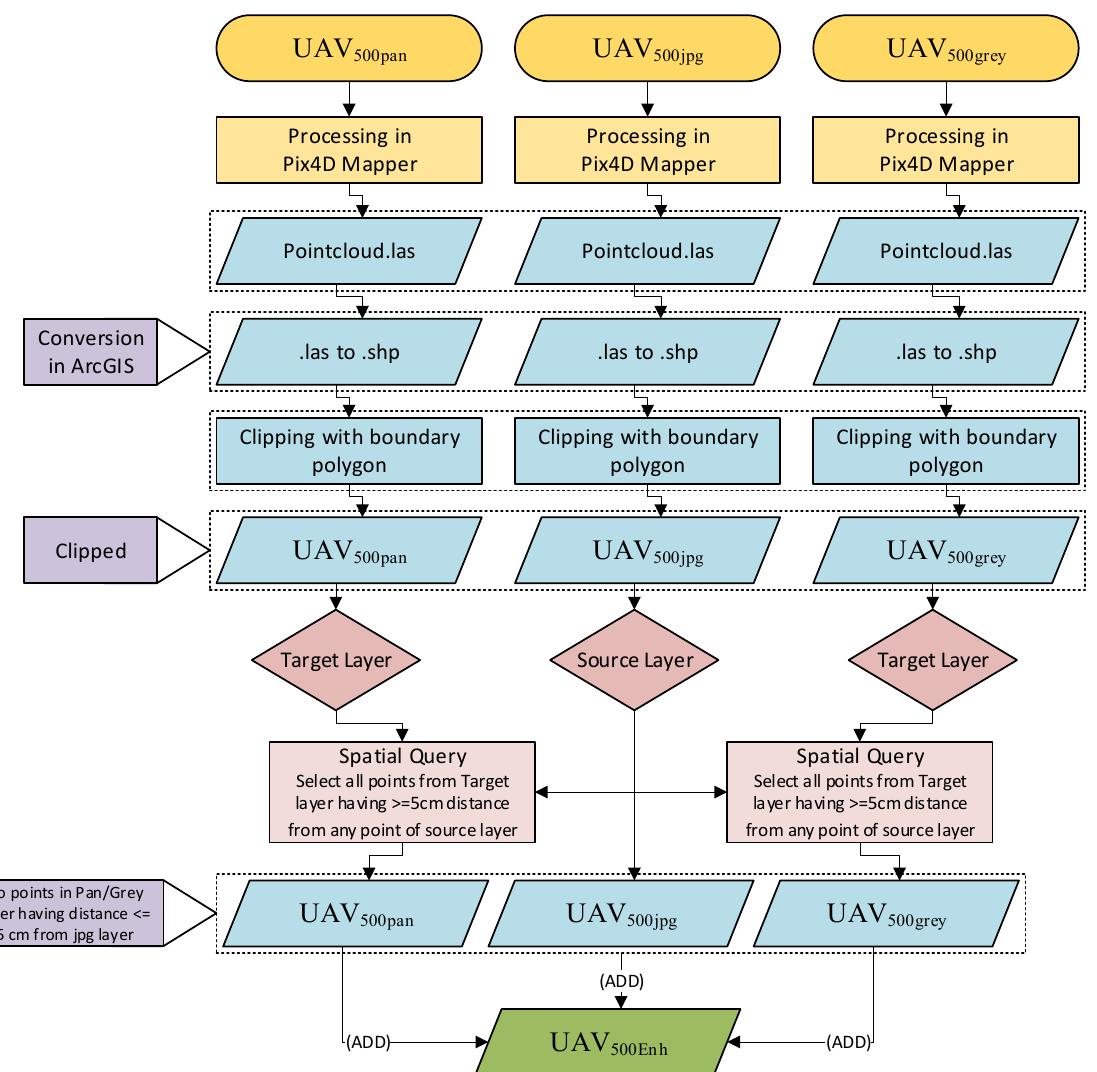
Figure 4. Point cloud merging and filtration.